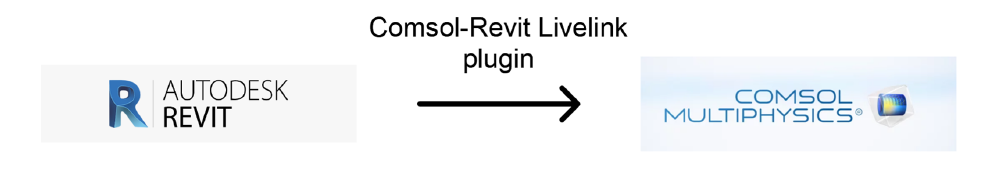
Figure 1. Closed BIM workflow based on Revit.